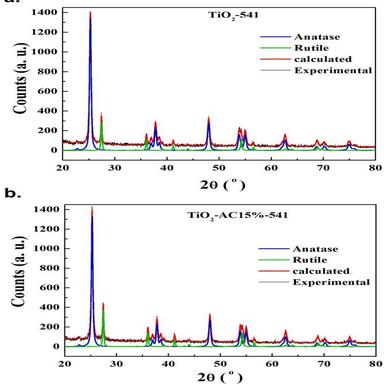
Experimental (black line) and calculated (colored lines) diffraction patterns of a) TiO2-541 and b) TiO2-AC15%-541samples. Calculated diffraction patterns of anatase (blue lines) and rutile (green lines) phases are shown compose the overall calculated diffraction patterns (red lines). Fig. 3. Experimental XRD pattern of AC-541.